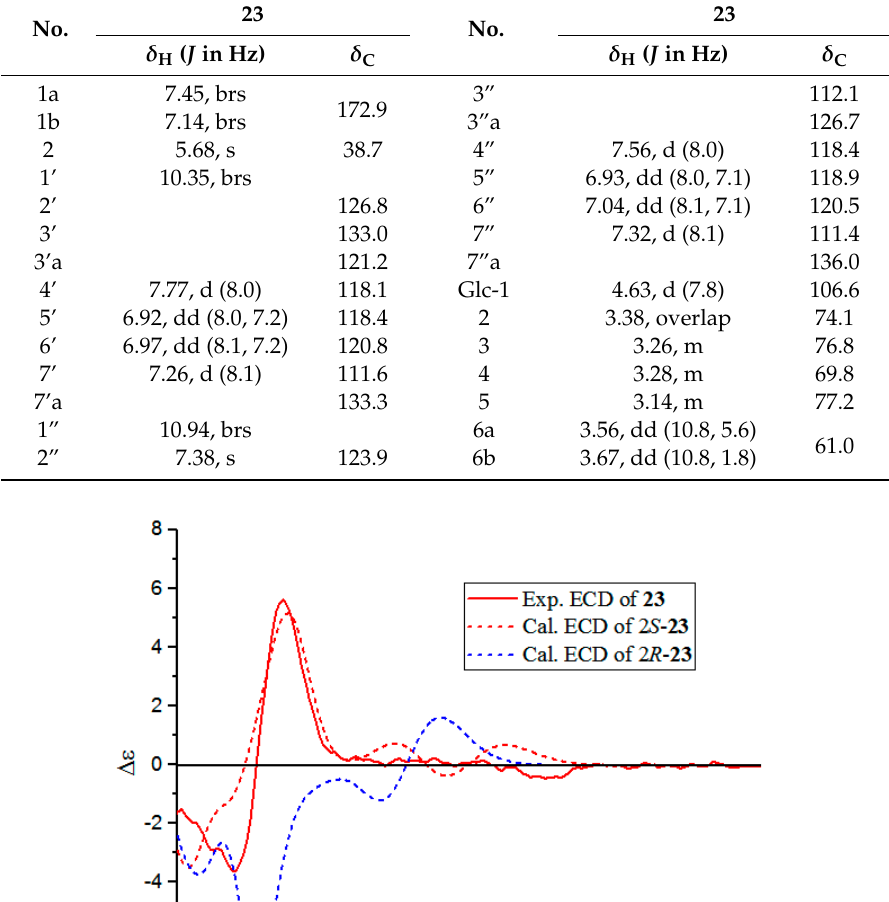
Table 2. 1 H-NMR (600 MHz in DMSO- d 6 ) and 13 C-NMR data (150 MHz in DMSO- d 6 ) of 23.